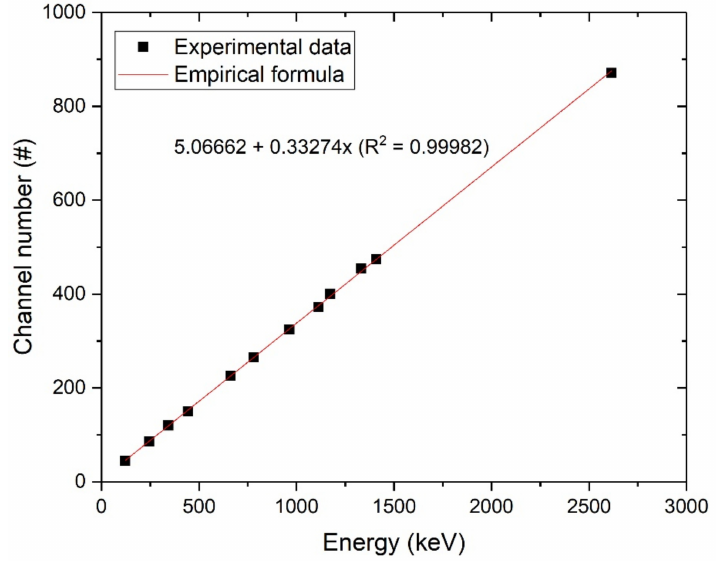
Figure 5. Linearity of channel numbers and energies.